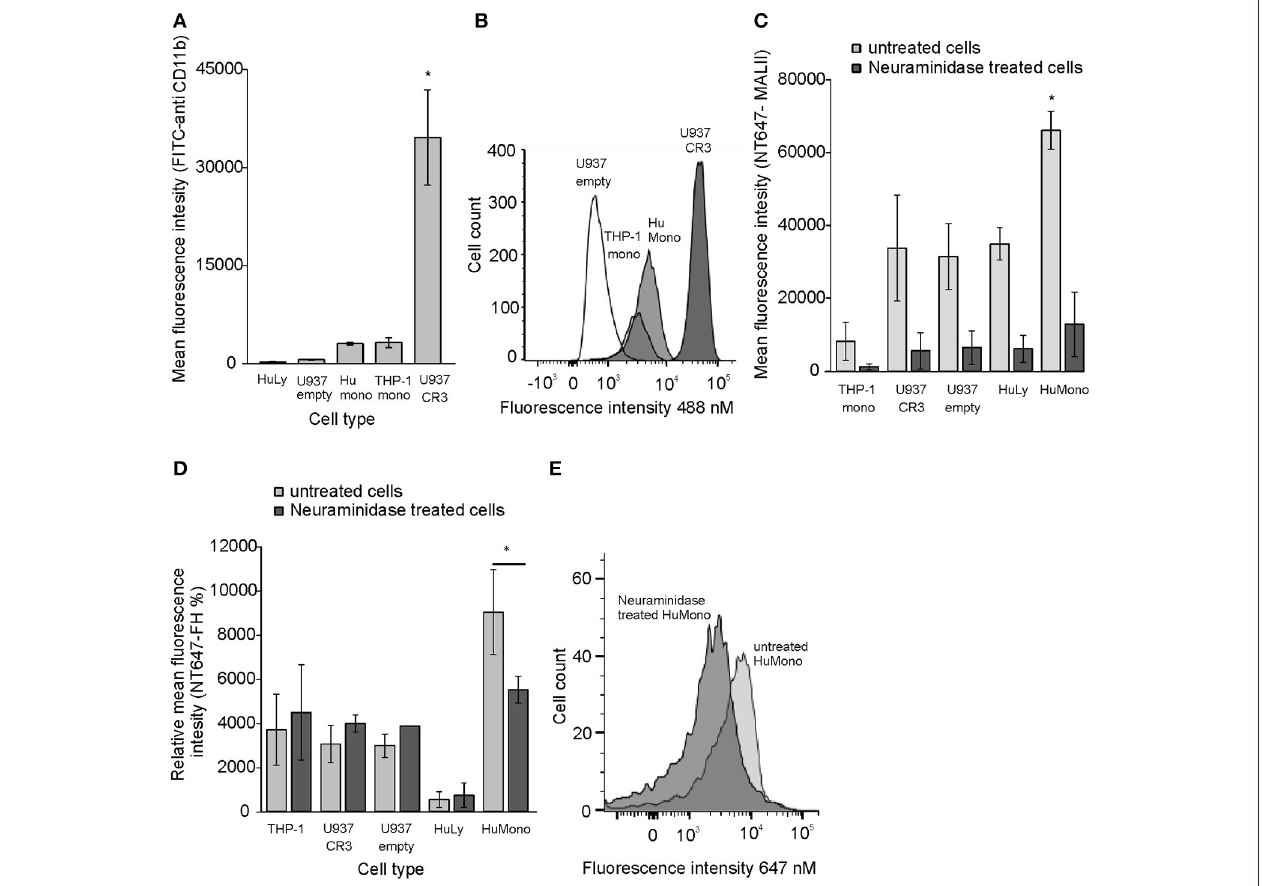
FIGURE 3 | CR3 and sialic acid expression and FH binding to neuraminidase treated cells. (A) The expression of CR3 in different cell types was tested using fluorescent labeled anti-CD11b antibody and flow cytometric analysis ( n = 4). (B) Histogram showing distribution of CR3 receptors in different cell types. (C) Binding of NT647 labeled Maackia amurensis lectin I (MAL II) to cell surface sialic acids in the presence or absence of 100U neuraminidase ( n = 3). (D) Binding of NT647 labeled FH on cell surface sialic acids in the presence or absence of 100U neuraminidase ( n = 3). (E) Binding of NT647 labeled FH on monocyte surface sialic acids in the presence or absence of 100U neuraminidase presented in a histogram. Percentages of mean fluorescence intensities is shown as relative to the intensity of neuraminidase treated U937 cells in each individual experiment. Histogram showing binding of NT647-FH on different cell types. Statistical significance between multiple samples was calculated using one-way ANOVA supplemented with Tamhane’s post-hoc multiple comparison test. Statistical significance between two samples was calculated using Mann-Whiney U -test. Error bars indicate SD. * = p <